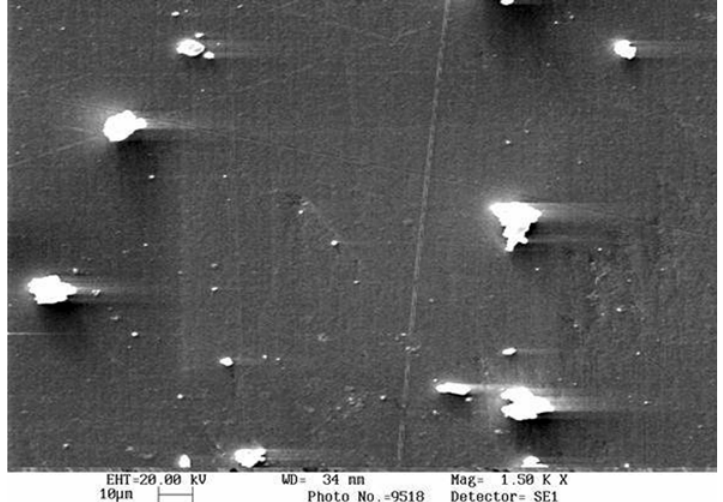
FIGURE 3- SEM micrograph of enamel surface subjected to immersion in artificial saliva (control group), presenting no erosions or porosities